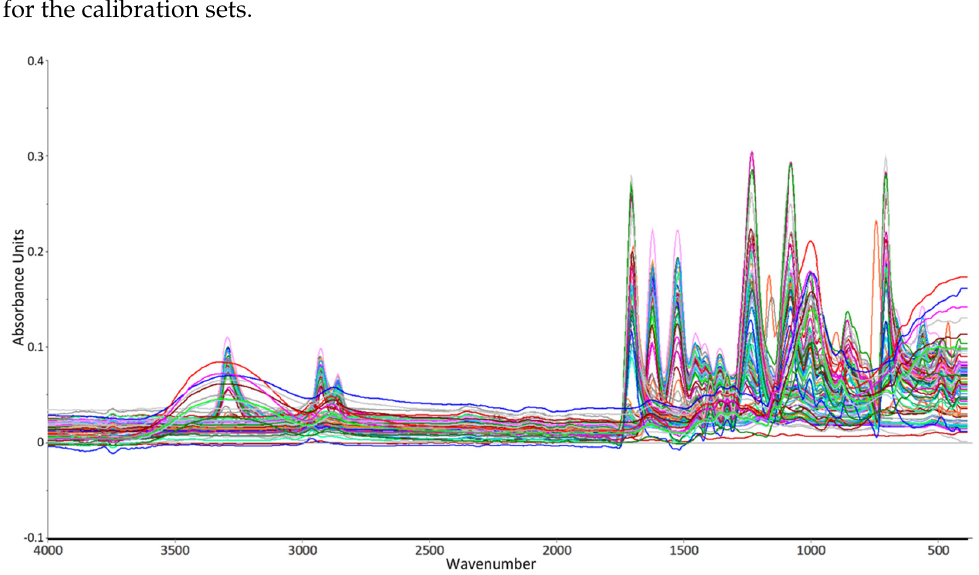
Figure 2. Spectra shape of all calibration